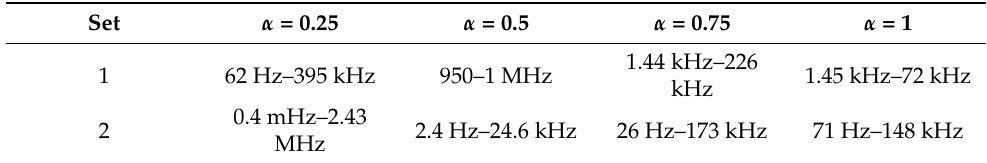
Table 3. Comparison of frequency ranges of FO inductance simulators for maximum phase error ± 2